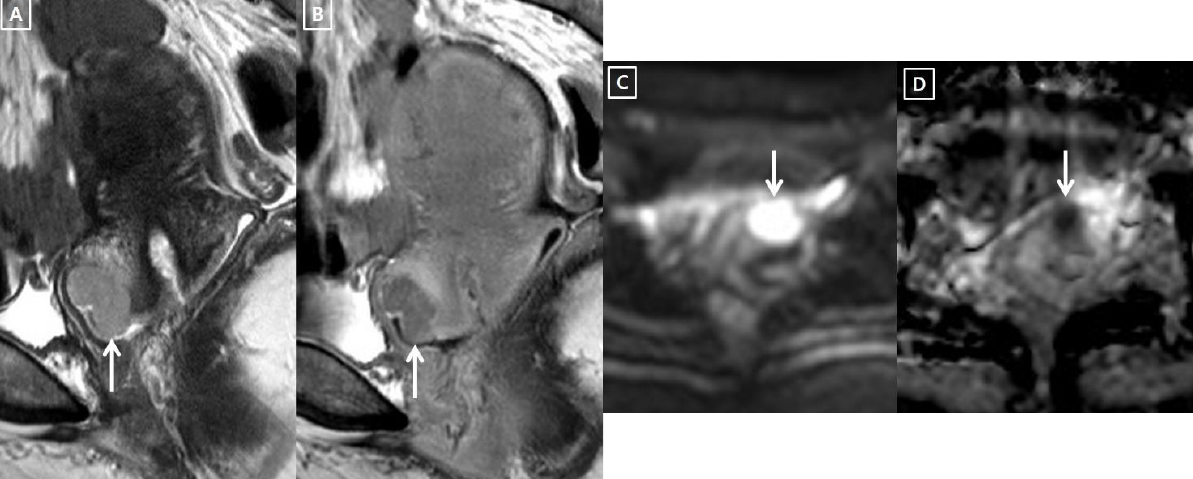
Figure 3. A 40-year-old woman with visible IB1 cervical cancer on 3T MRI. ( A , B ). T2-weighted sagittal MR image following colposcopic biopsy show a slightly hyperintense cervical cancer. This tumor shows poor enhancement on delayed contrast-enhanced sagittal MR image. ( C , D ). The diffusion-weighted axial MR image shows a hyperintense cervical mass (white arrow), suggesting strong diffusion restriction. The tumor (white arrow) is hypointense on an apparent diffusion coefficient axial MR image. The radical hysterectomy specimen showed a 20 mm residual cancer (Glassy cell carcinoma) and 40.0% invasion depth. Four metastatic lymph nodes were detected even though there was no invasion into the parametrium, vagina, and LVS.